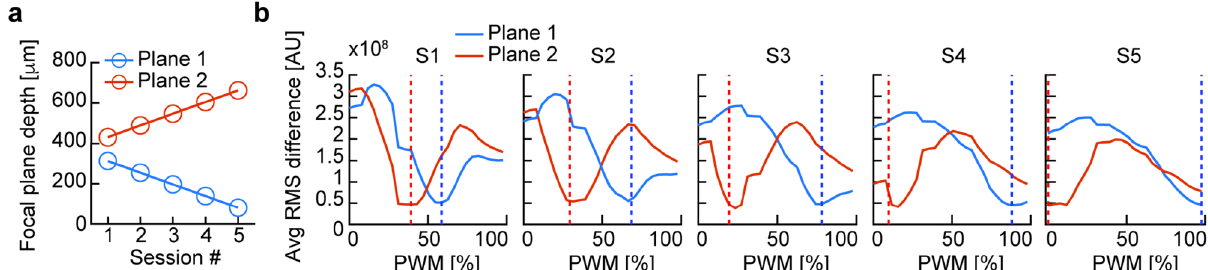
Figure 3. Focal plane fast switch. ( a ) Focal plane depth (estimated using the linear fit from Fig. 2c) for 5 sessions recorded alternating between two focal planes every frame, with 100 frames recorded at each depth. ( b ) Average pixel intensity RMS for the image difference between the average of 100 frames recorded at each of the alternating plane depths (red and blue for plane 1 and plane 2, respectively), and frames recorded statically across all PWM cycle control values. Dashed lines mark the PWM cycle used on each of the two planes. Local minima of the RMS difference curve denote higher similarity between the two